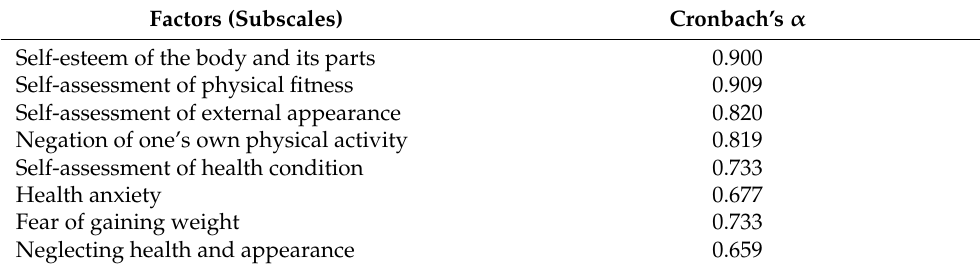
Table 4. Cronbach’s alpha reliability coefficients for subscales of the MBRSQ-PL